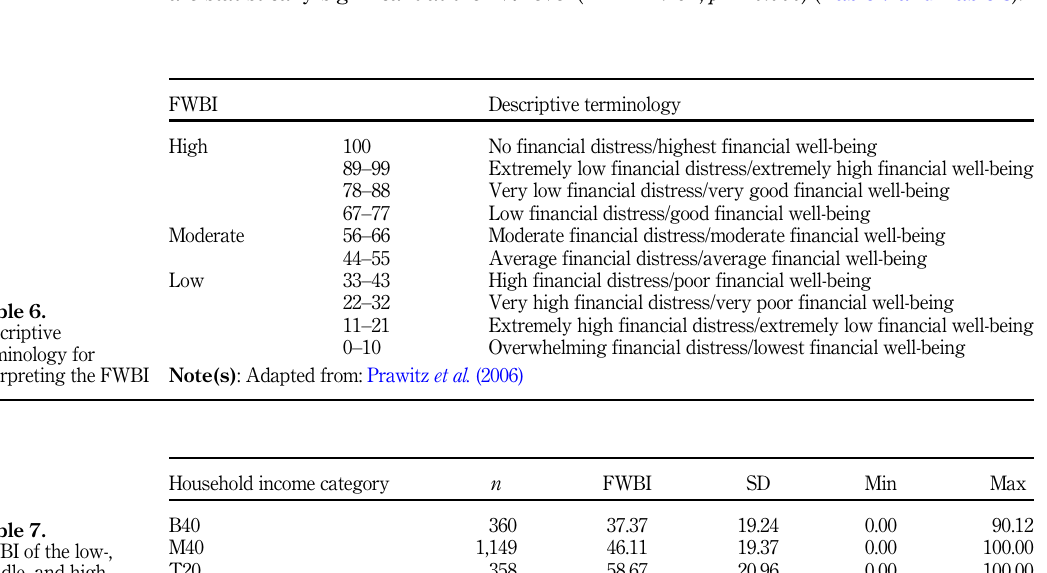
middle- and high income